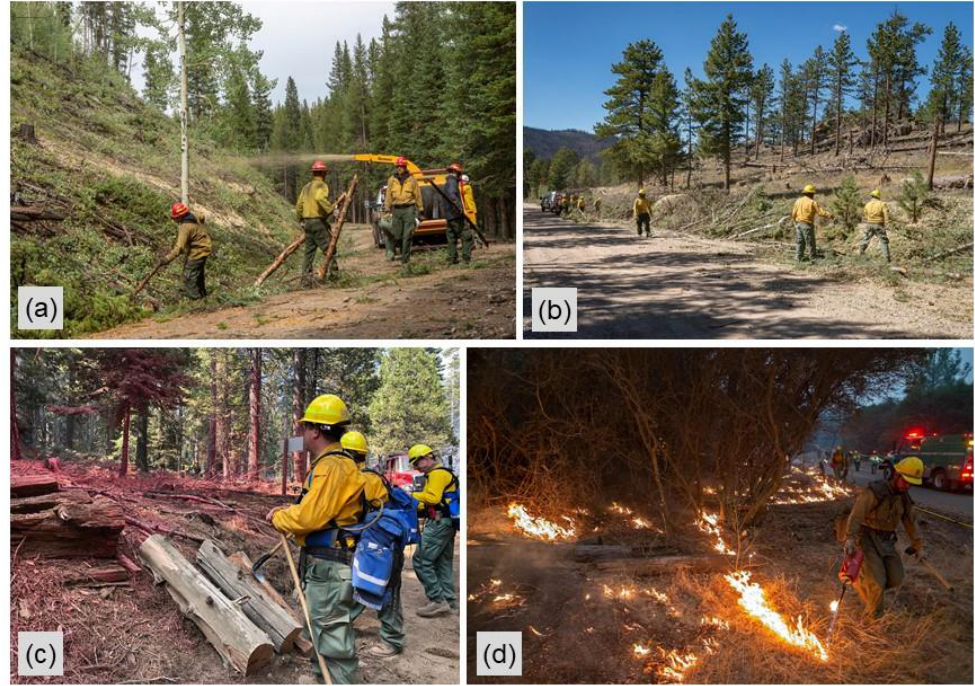
Figure 1. Various forms of indirect fire line preparation using roads: ( a , b ) Roadside brushing and chipping; ( c ) Retardant application adjacent to road to be used as line; and ( d ) Burnout operation anchored to a road. All photos are from [21].